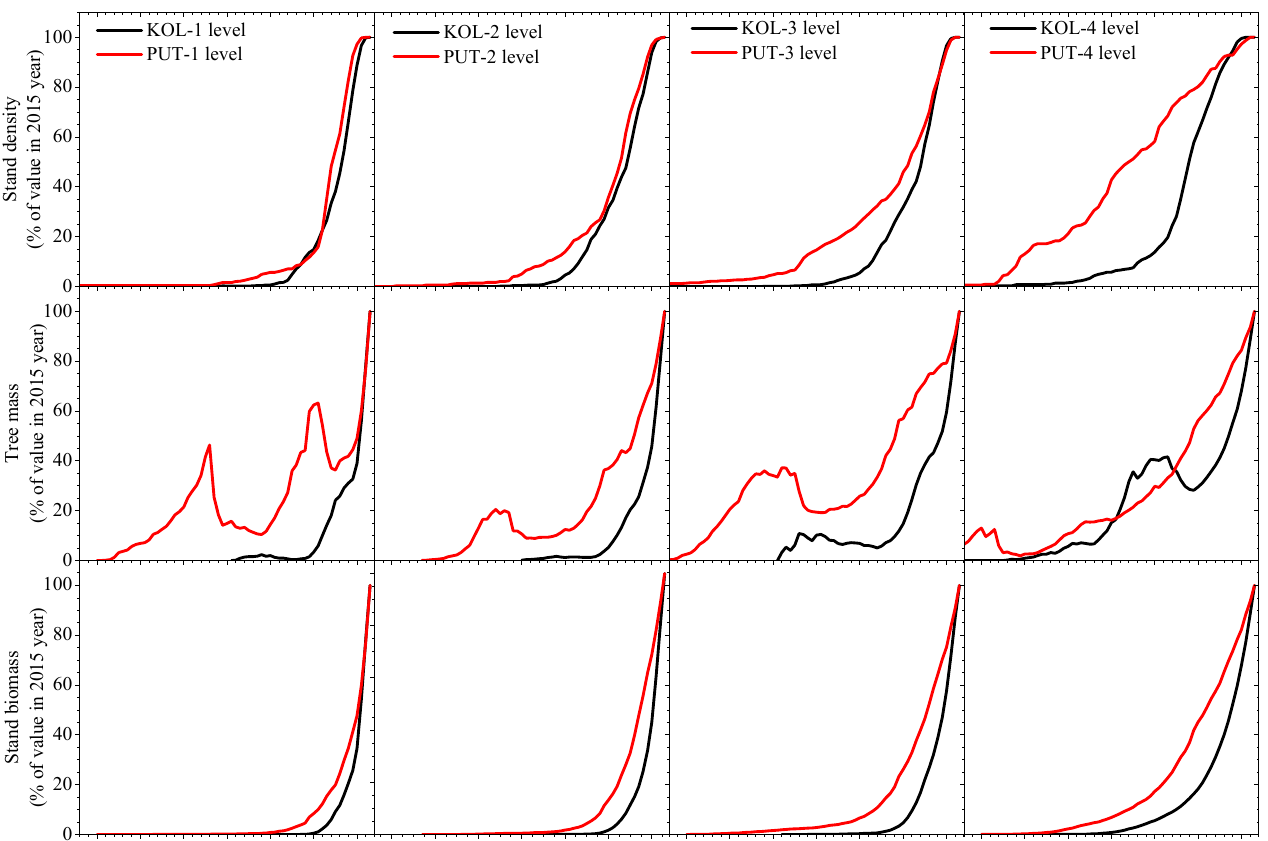
Figure 7. Comparison of changes of average tree mass, stand density, and biomass since the year 1680 on different levels in the forest–tundra transition on the slopes of the Kola Peninsula (KOA) and the Putorana Plateau (PUT): 1 level—sparse tree stand line; 2 level—open forest line; 3 level— contemporary closed forest line; and 4 level—historical (in 1950s–1960s) closed forest line.